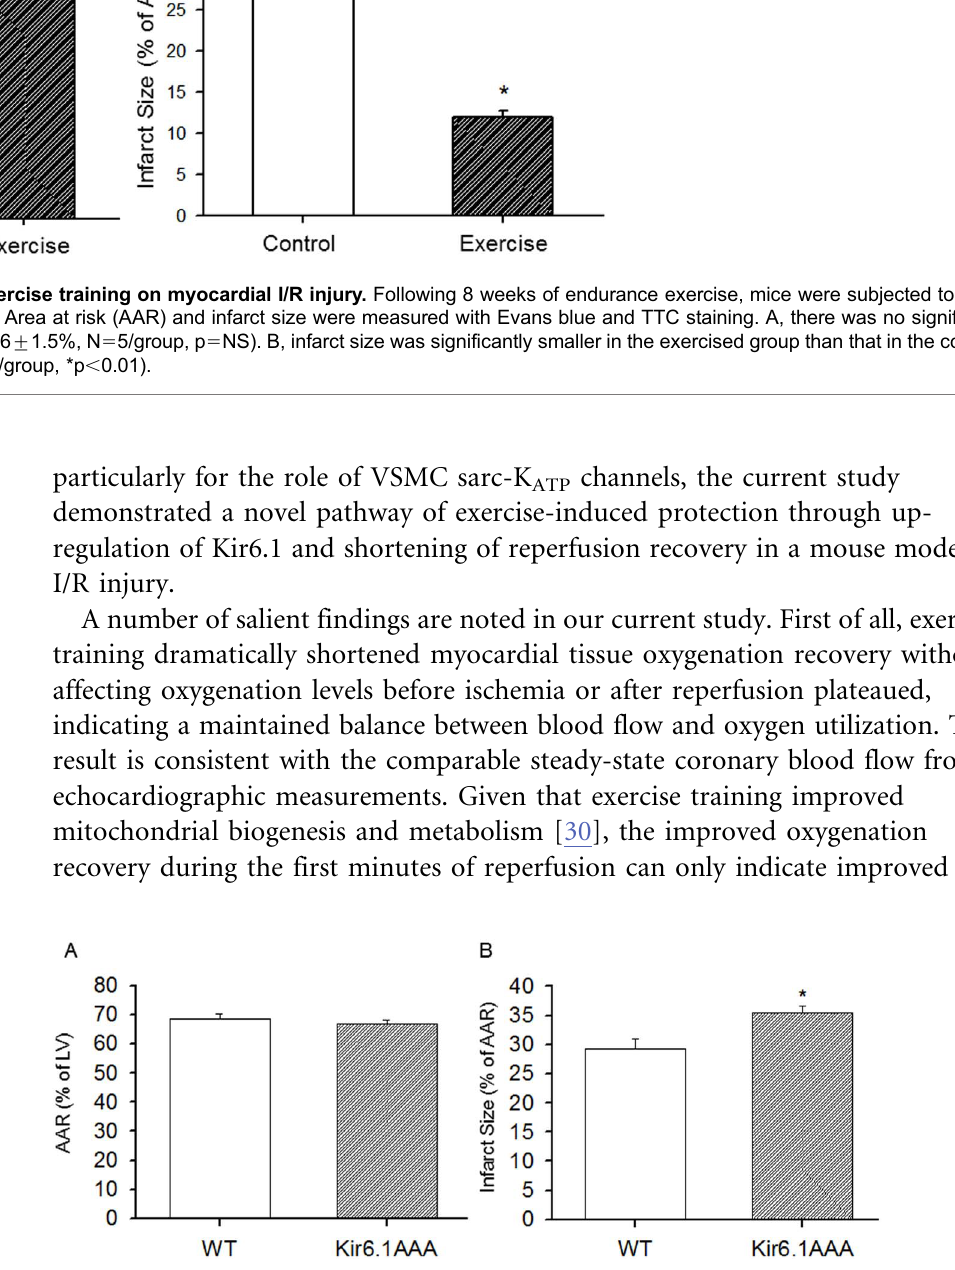
Figure 8. The effect of Kir6.1AAA transfection on myocardial I/R injury in non-exercised mice. After 1 week of Ad-Kir6.1AAA-GFP transfection, control mice (WT) were subjected to LAD occlusion followed by 24 h reperfusion. AAR (A) and infarct size (B) were measured with Evans blue and TTC staining. As shown, there was no significant difference in the AAR, but infarct size was increased , 21% in the transfected group. N 5 7/ group, *p ,